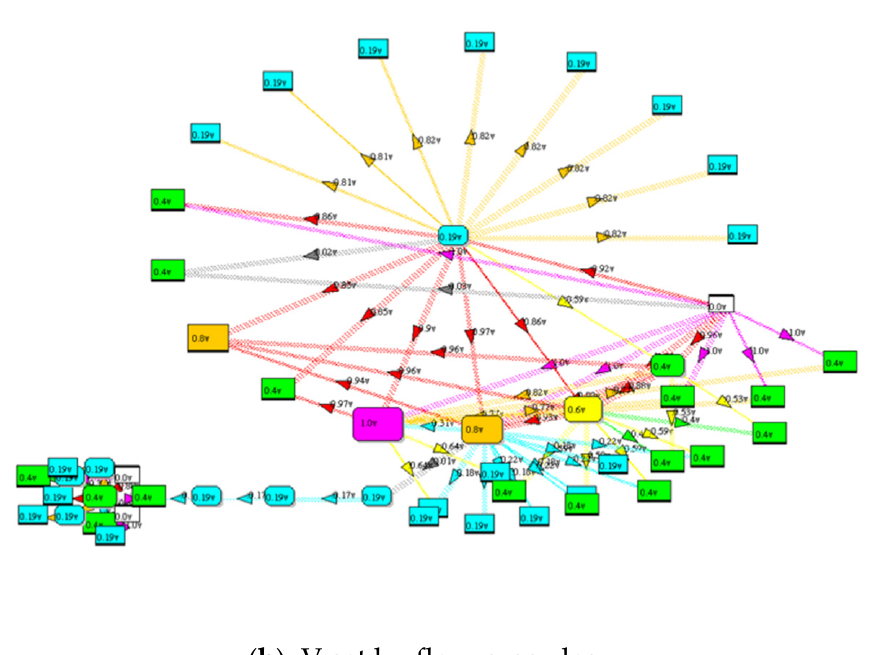
Figure 11. Predicting future failure of nodes/links in a network is computed by simulating the number of times a node/link is faulted cF as illustrated here for the Industrial Control system network. Colored heat maps of ( a ) Result for t = 10,000 simulated viral cascades and ( b ) result for N-k link overload cascades.